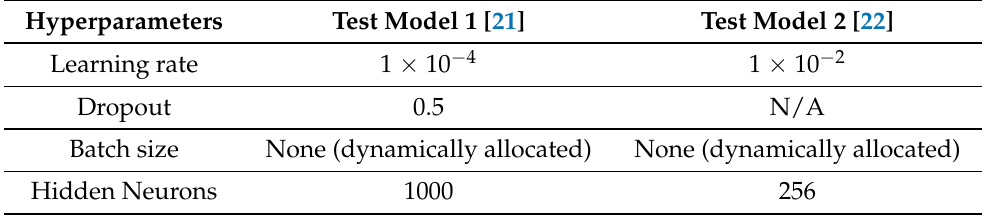
Table 5. Hyperparameters of Test Model 1 and Test Model